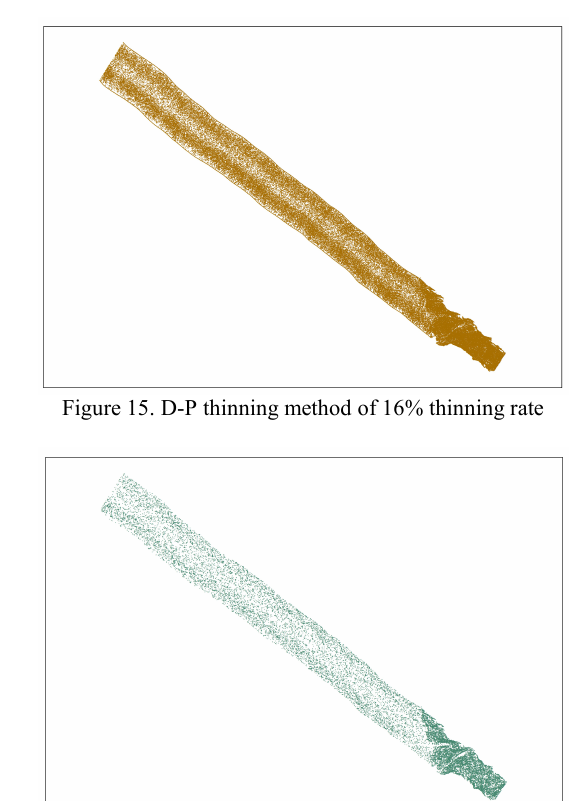
Figure 10. System-based thinning method of 5% thinning rate